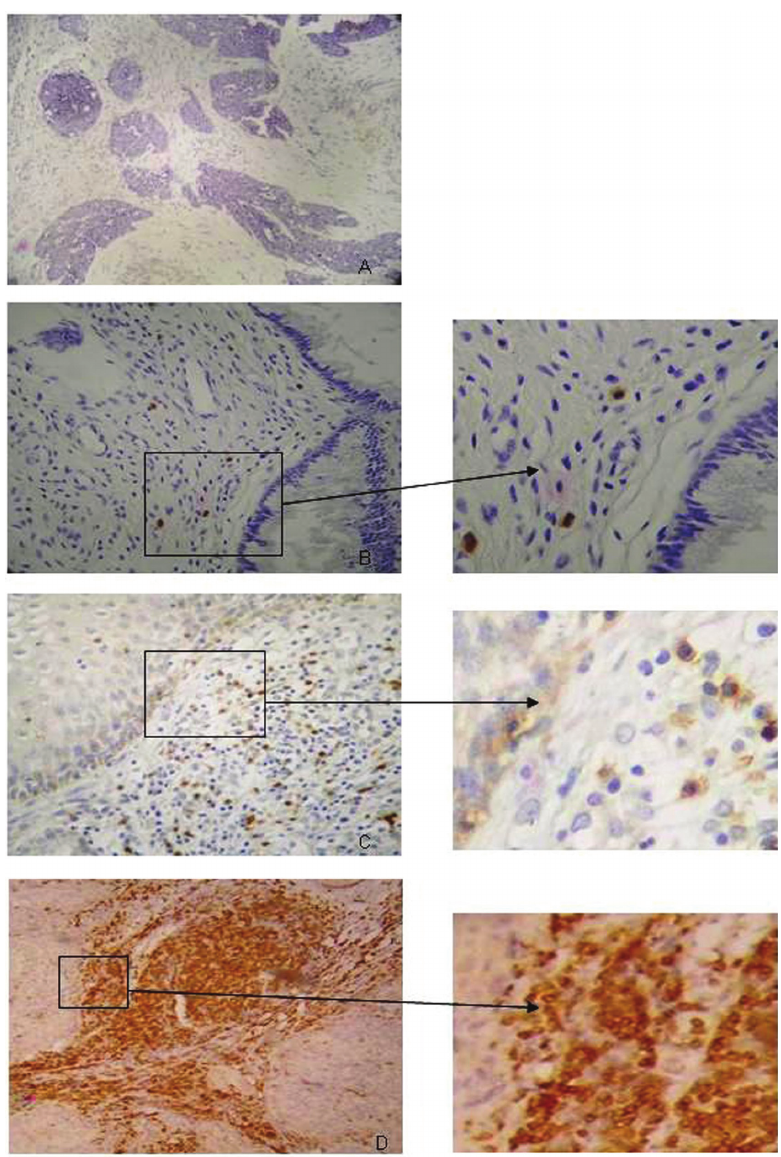
Figure 1 -.Samples of stained tissue sections. Histological analysis of tissue stained by CD3 immunohistochemistry shows positive cells (in brown; B, C and D) with a score of 0 (A), 1 (B), 2 (C) or 3 (D), as described in the “Materials and Methods” section. Magnification: